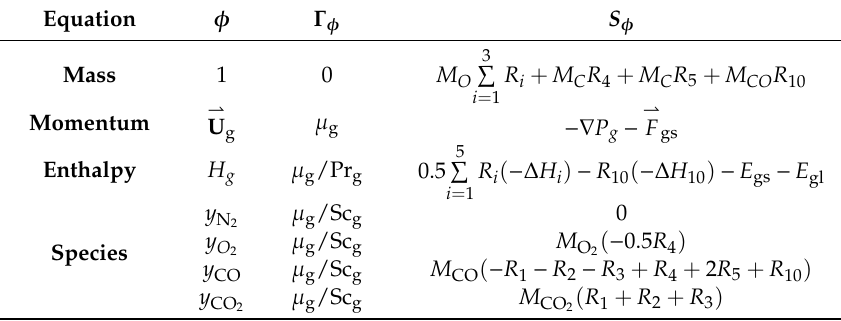
Table 5. Terms in Equation (1) for the gas